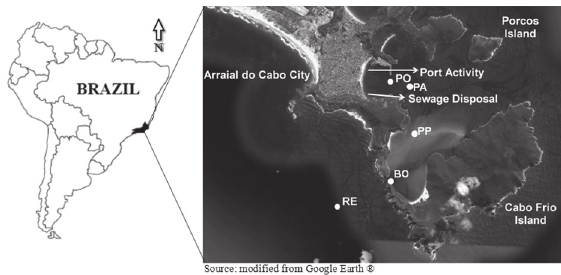
Figure 1 - Sampling stations in the Extractive Reserve of Arraial do Cabo (Cabo Frio region, Rio de Janeiro – Brazil). Upwelling is common offshore (RE) while PO and PA are the areas more impacted by anthropogenic